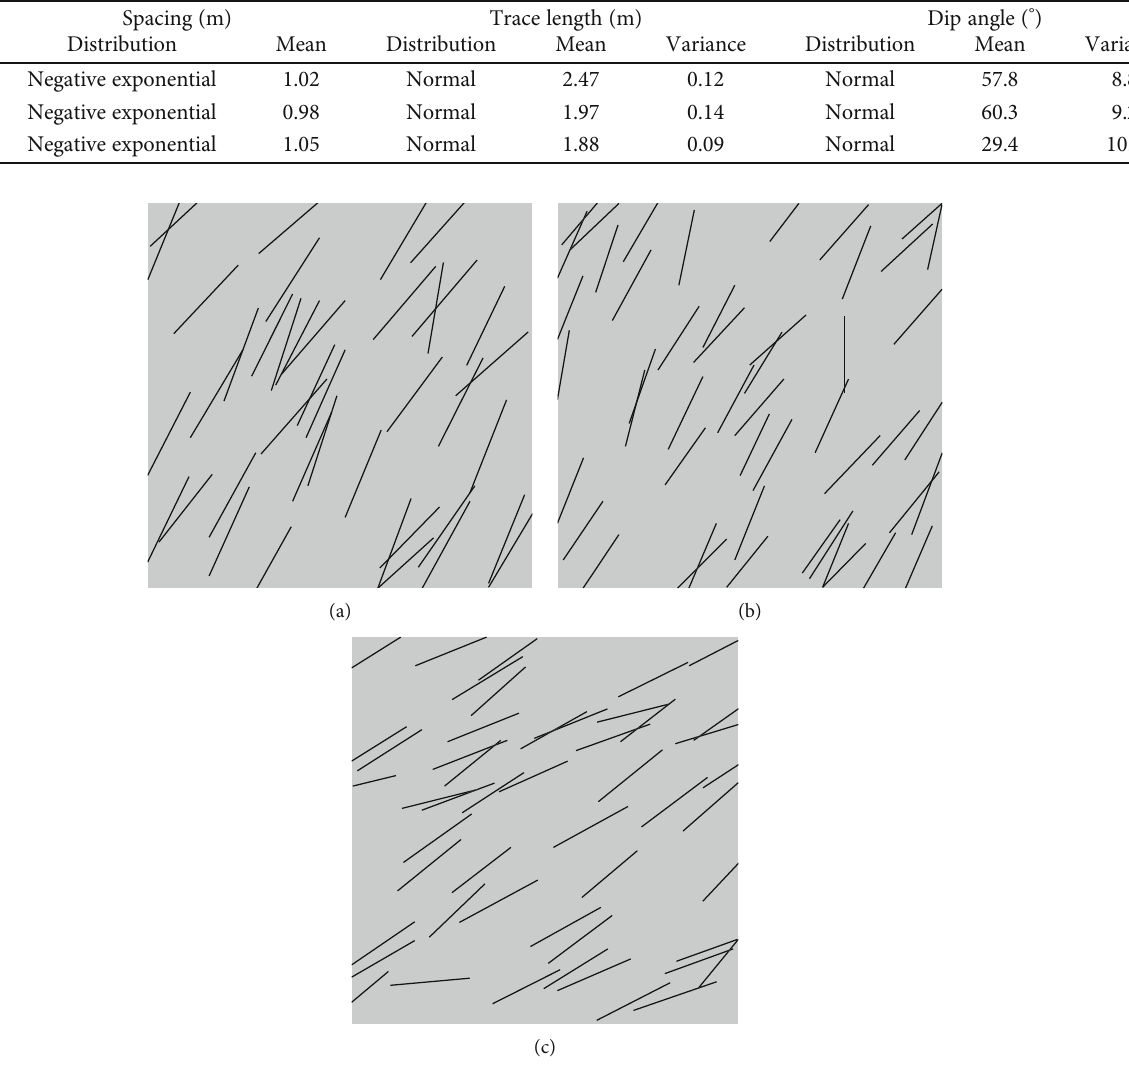
Figure 5: Joint network model of di ff erent groups: S1; S2; S3. Table 2: Sample capacity statistics for di ff erent sampling